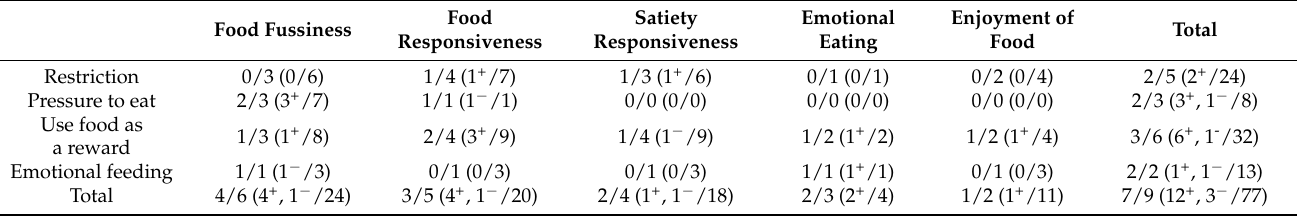
Table 4. Summary of longitudinal effects from child eating behaviors to feeding practices (E →